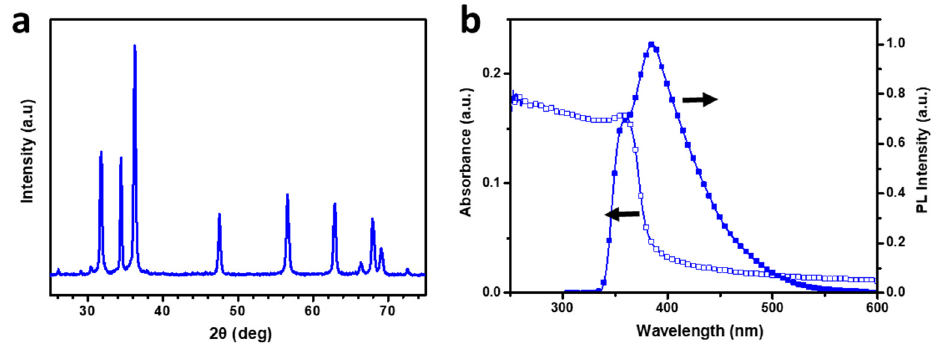
Figure 4. ( a ) XRD pattern and ( b ) UV–Vis absorption and PL spectra of a ZnO layer.